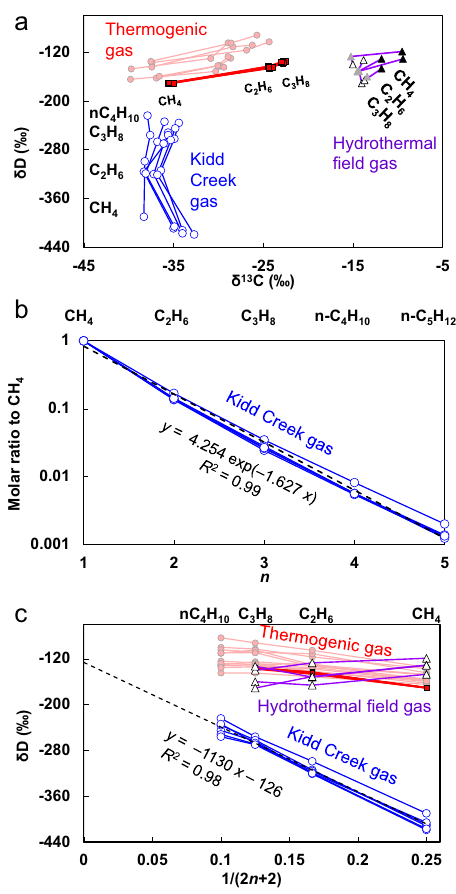
Fig. 1 Distinct geochemical signatures of the Kidd Creek gas. a δ 13 C versus δ D. b Distribution of alkane abundances (relative to CH 4 ). c δ D against the reciprocal of hydrogen number of alkanes. Blue lines — Kidd Creek gas (depth > 2500 m) 4,5 ; violet — hydrothermal fi eld gas data from the Lost City of Mid-Atlantic Ridge 12 , black, grey, and white triangles stand for methane, ethane, and propane, respectively; pink — thermogenic gas data from NW Australia Shelf 17 ; red — thermogenic gas data from NW Sichuan Basin, China 18 ; black dashed lines — linear trend lines of the Kidd Creek